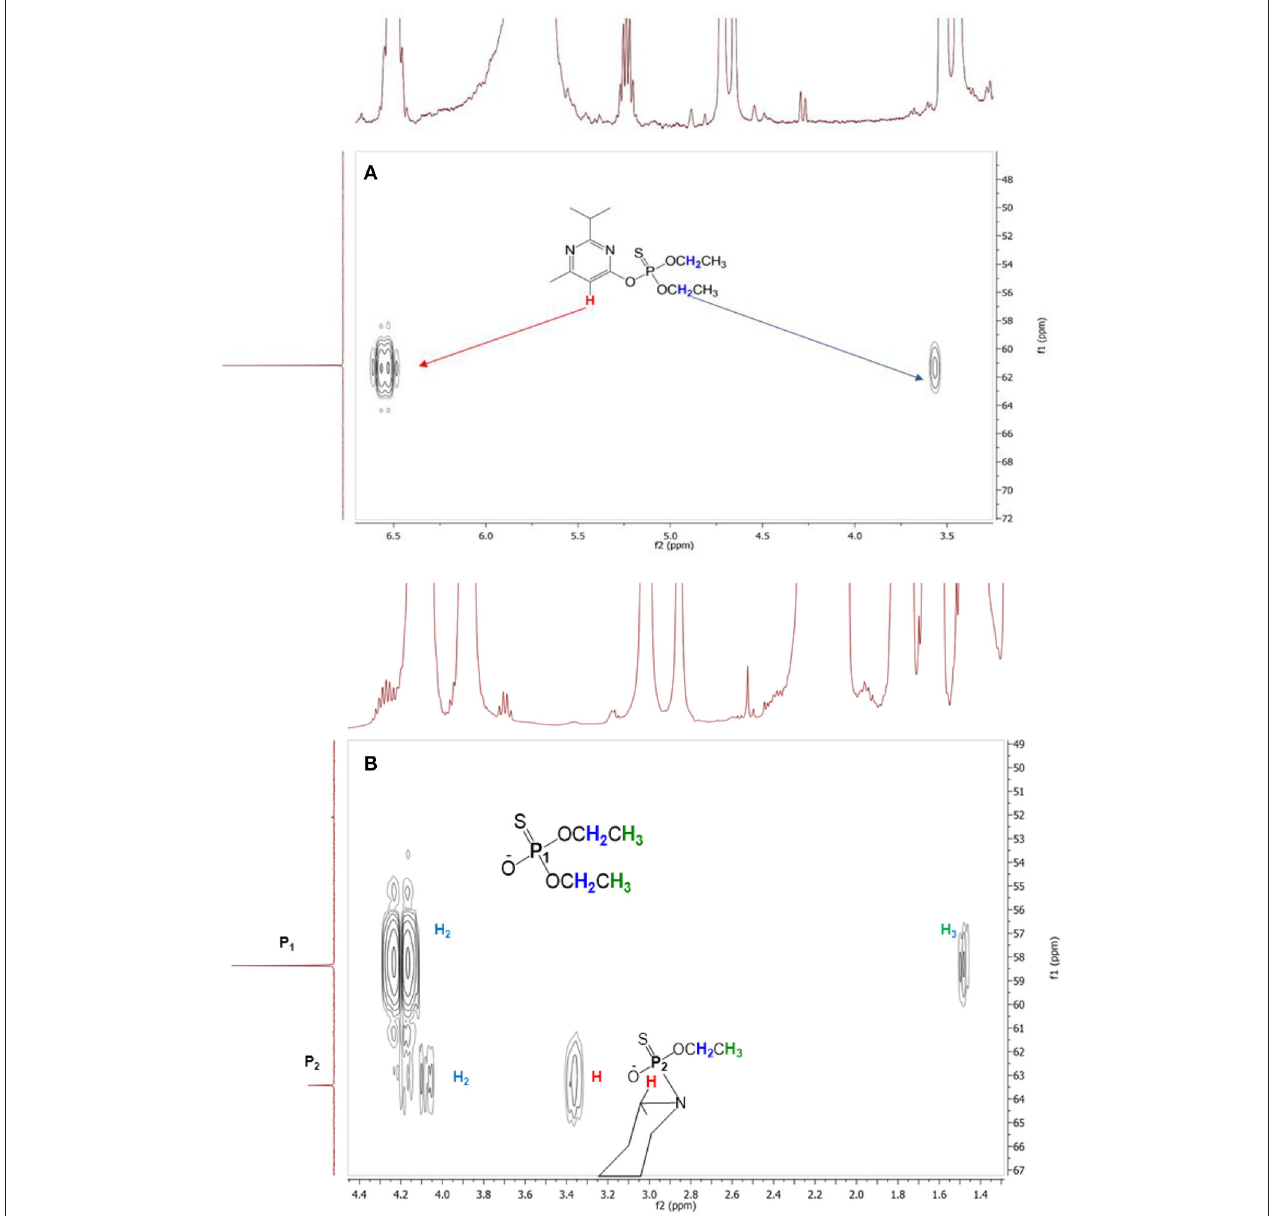
FIGURE 6 | 2D 31 P- 1 H HMBC experiment of the reaction of Diazinon with piperidine in 2-Me THF at 25 ◦ C at the beginning (A) and at the end (B) of the